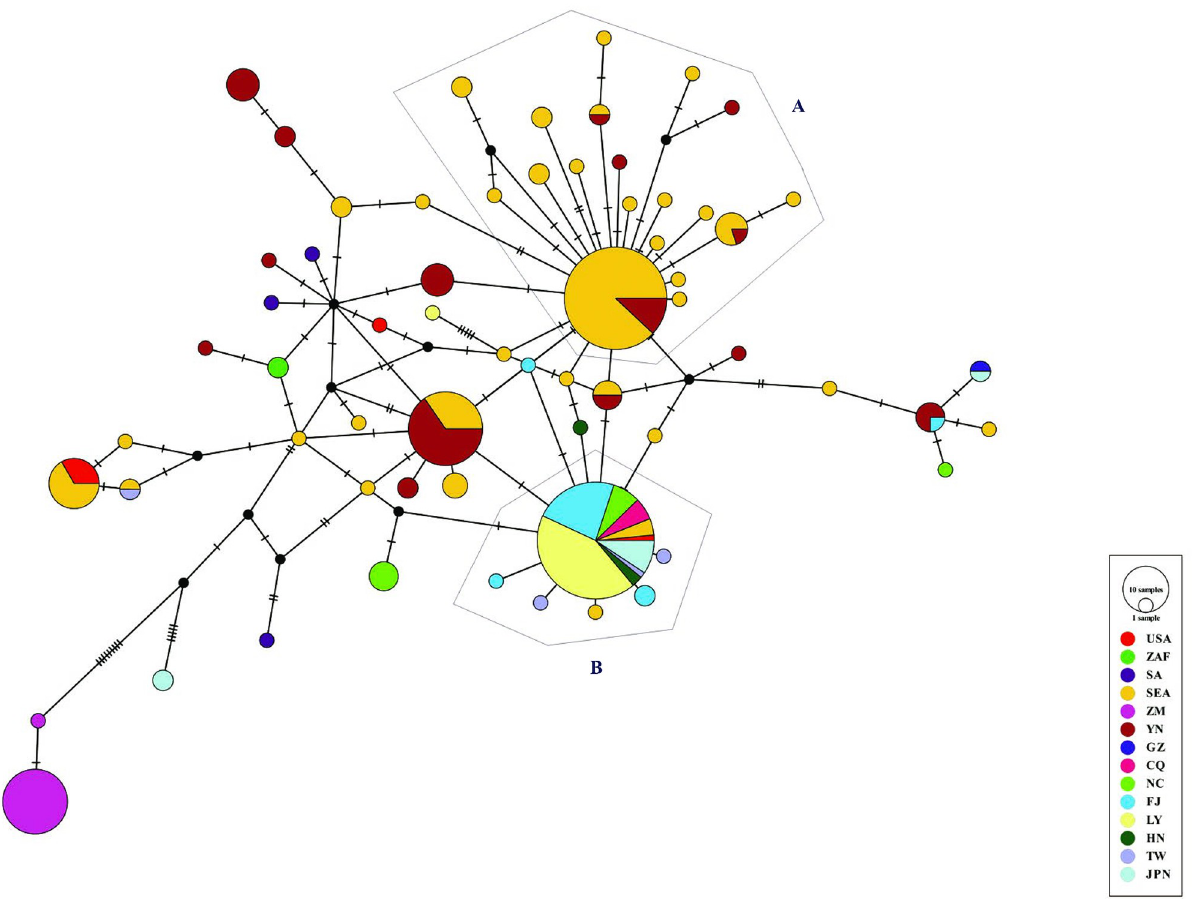
Fig 2. Haplotype network of R . tanezumi based on the Cytb gene of mtDNA. See S1 Table for a full description of Cytb sequences.